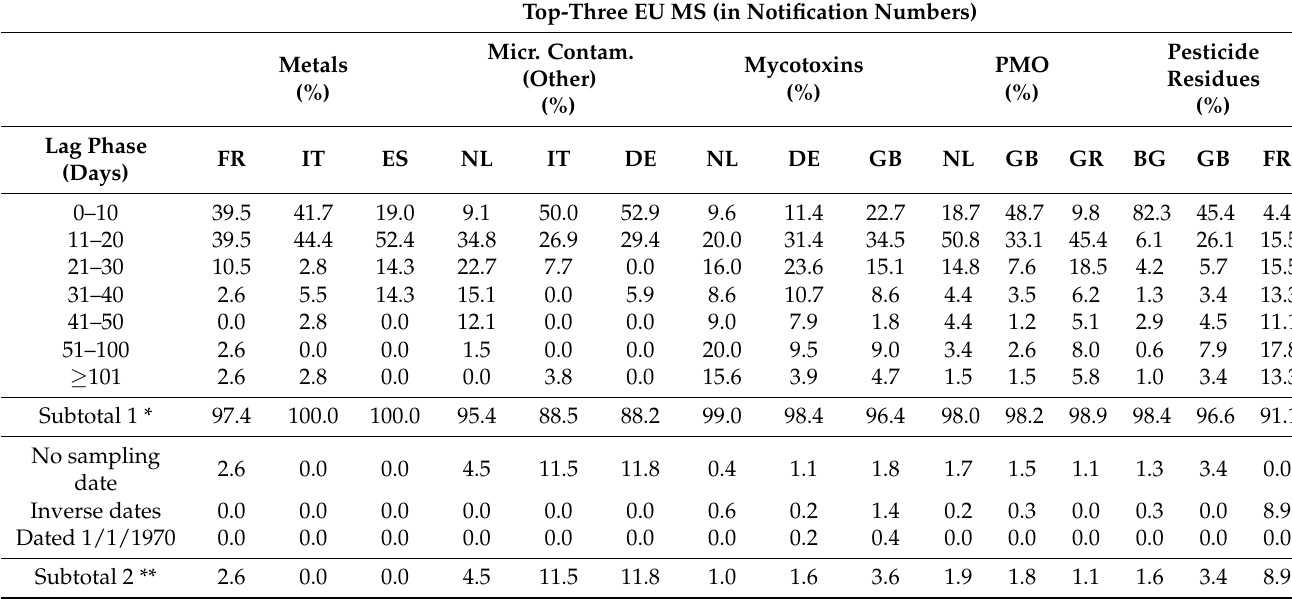
Table 8. Percent (%) share of lag phases in serious border rejection (sBR) notifications in the top-three EU RASFF MSs in each of the five food hazard categories (mycotoxins, microbial contaminants (other), pesticide residues, metals, PMO), according to the EU RASFF database